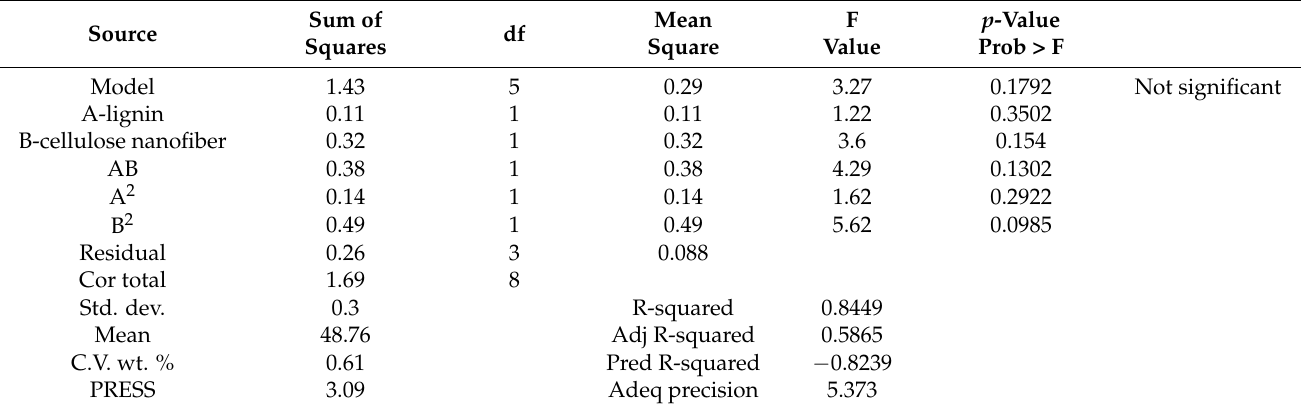
Table 5. ANOVA for response surface quadratic model for PE of lignin–cellulose nanofiber-filled thermoplastic starch composite